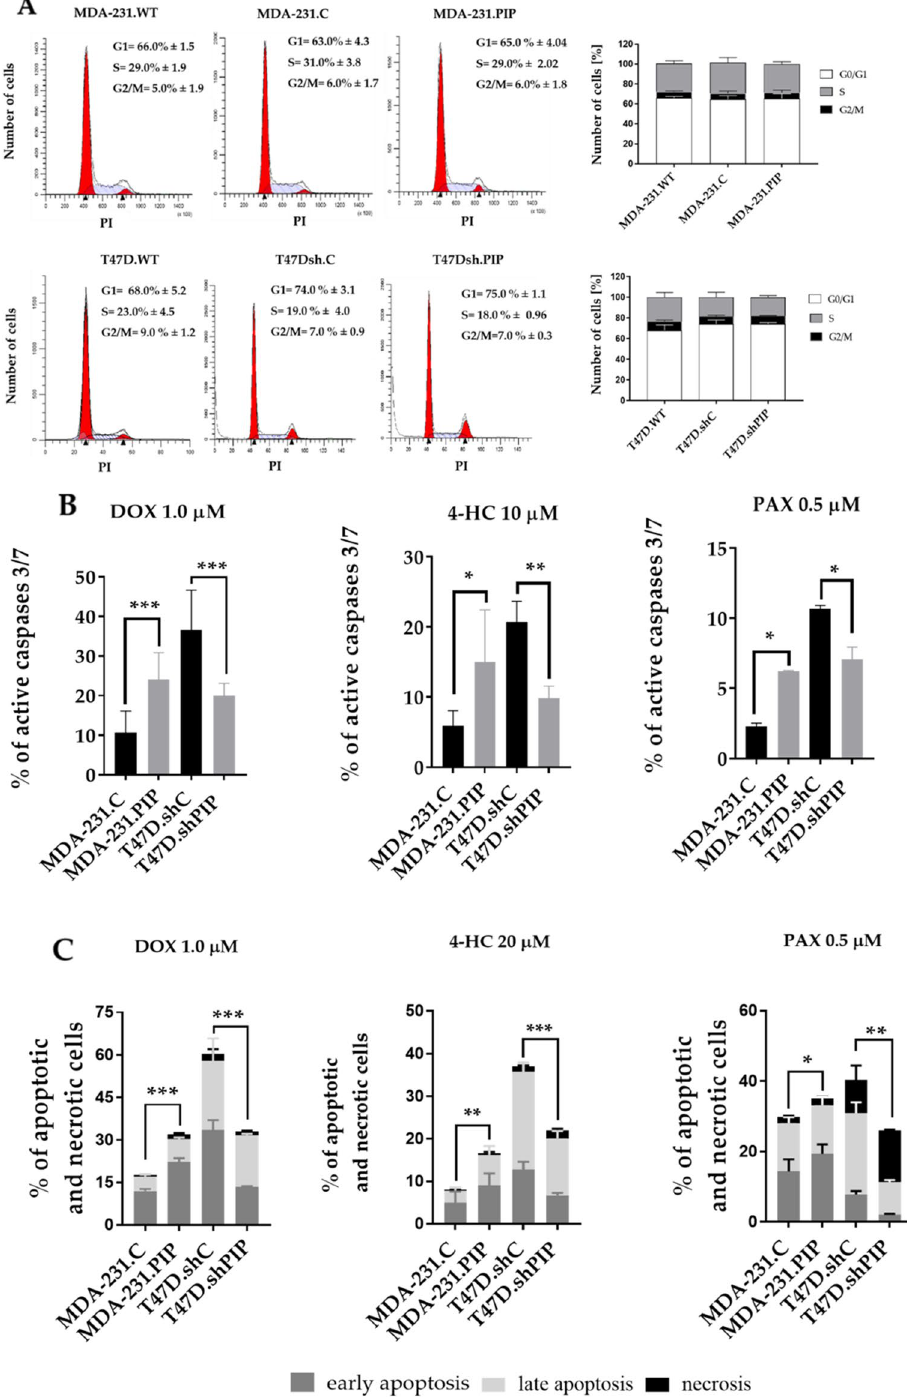
Figure 2. Proliferative potential of breast cancer (BC) MDA-MB-231 and T47D cells with different PIP expression. ( A ) Cell cycle progression after 48 h in parental MDA-MB-231 cells (MDA-231.WT), control MDA-MB-231 transduced with the vector alone (MDA-231.C) and MDA-MB-231 cells overexpressing PIP (MDA-231.PIP), parental T47D cells (T47D.WT), control T47D transduced with the vector alone (T47D.shC) and T47D cells with the suppressed expression of the PIP gene (T47D.shPIP). The number of cell nuclei in a given phase of the cell cycle was calculated by flow cytometry after staining with FxCellcycle PI/RNAse solution (see “Materials and methods”). Data are presented as the average of three independent measurements (n = 3). Sensitivity of BC MDA-MB-231 and T47D cells with varying expression of PIP to apoptosis induced by DOX, 4-HC, and PAX. Cells grown in the presence of anti-cancer drugs for 48 h were ( B ) analyzed according to the presence of active forms of caspase-3 and-7 (CaspGLOW™ Fluorescein Active Caspase-3/7 Staining Kit) or ( C ) stained with Annexin V and propidium iodide (FITC Annexin V Apoptosis Detection Kit). Data represent the mean ± SD of three independent measurements. Statistically significant differences (* p < 0.1, ** p < 0.01, *** p <